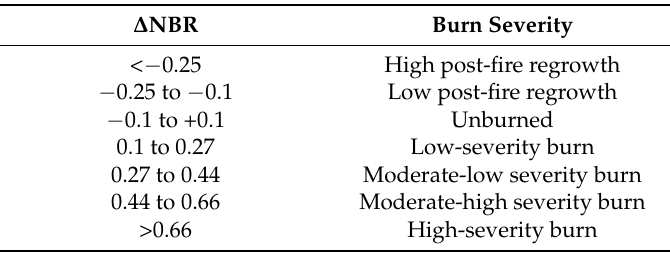
Table 2. Burn severity categories.